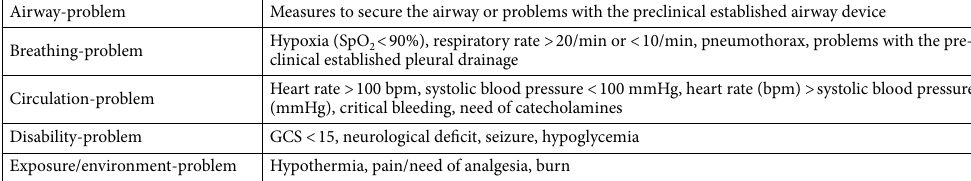
Table 1. Definitions used to assess the patient’s ABCDE-Status at admission at the trauma resuscitation